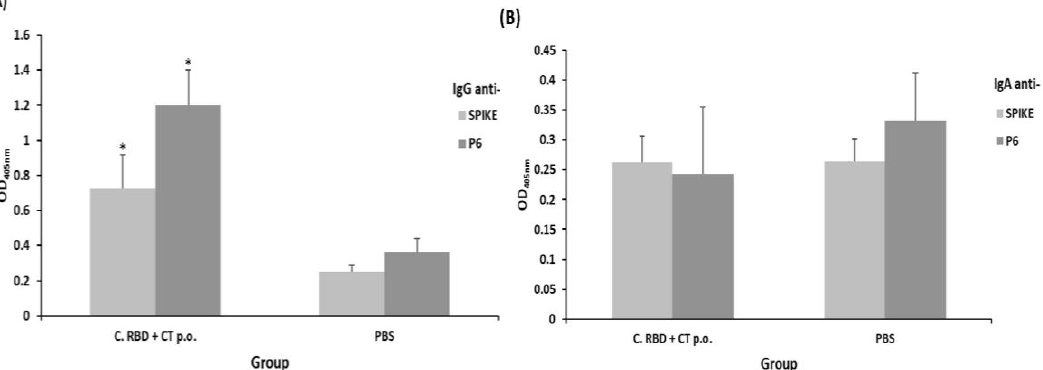
Figure 5. Evaluation of humoral response (IgA and IgG) at the mouth induced by the algae-made RBD. IgG ( A ) and IgA ( B ) antibodies were measured in saliva (1:4 dilution) by ELISA using either spike or P6 as the target antigen. Error bars represent standard deviations. * denotes statistically significant differences versus the PBS group ( p < 0.05).